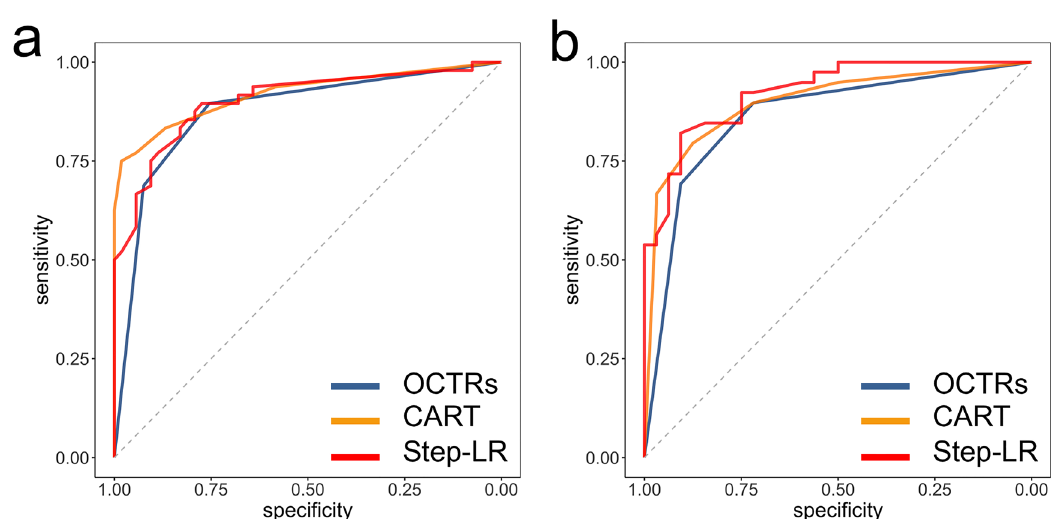
Figure 4. ROC curves of the final radiological ( a ) and clinical-radiological ( b ) multivariate models in the independent validation cohort. CART classification and regression tree; Step-LR stepwise binary logistic